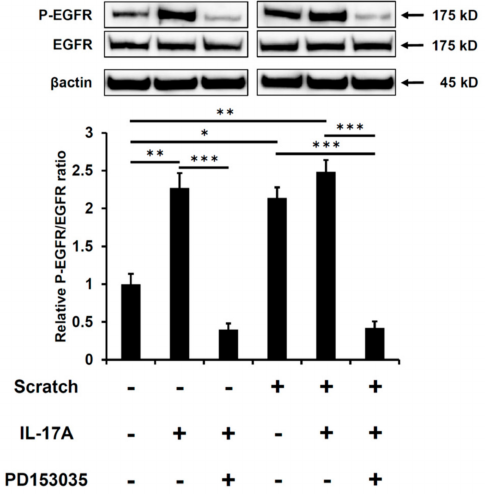
Figure 7. IL-17A upregulates the phosphorylation of EGFR at 3 h after scratching. The phosphorylation of EGFR was measured by western blot in non-scratched control keratinocytes and scratched-keratinocytes in the presence or absence of IL-17A (1 ng / mL) or PD153035 (EGFR inhibitor, 300 nM). Representative blot images of three independent experiments and the relative expressions of phosphorylated proteins are shown. * p < 0.05. ** p < 0.01. *** p <